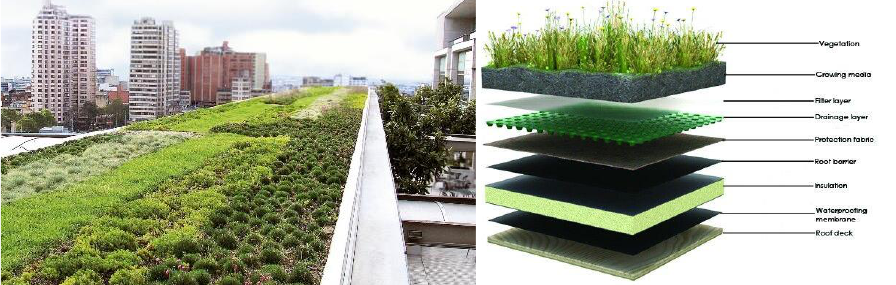
Figure 4. Green roof and its consisting layers.